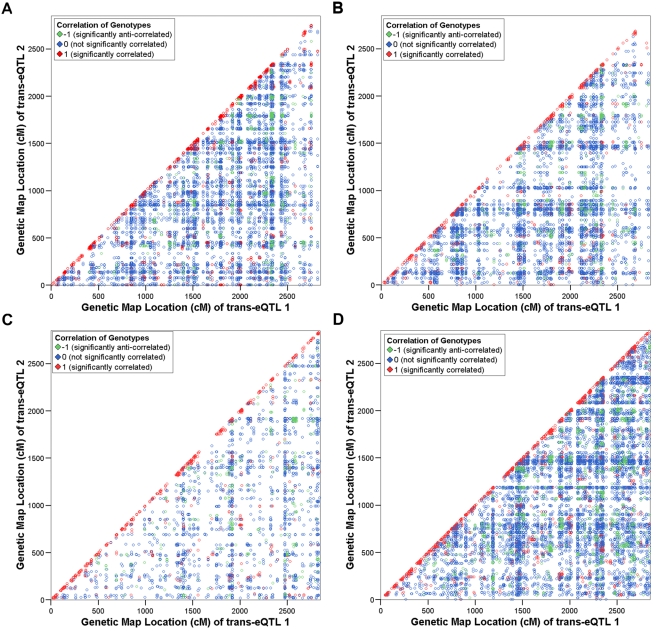
Scatter plots showing pairs of trans-eQTL genes with significantly correlated expression profiles by genetic map location of peak of linkage.Significantly correlated pairs of trans-eQTLs identified in a) fat, b) kidney, c) adrenal and d) left ventricle are plotted according to genetic map position of the peak of linkage. Colour coding is as in Figure 1. Over-representation of pairs of trans-eQTLs with nearby peaks of linkage among the significantly correlated set can be observed (in the red diagonal) in all four tissues.